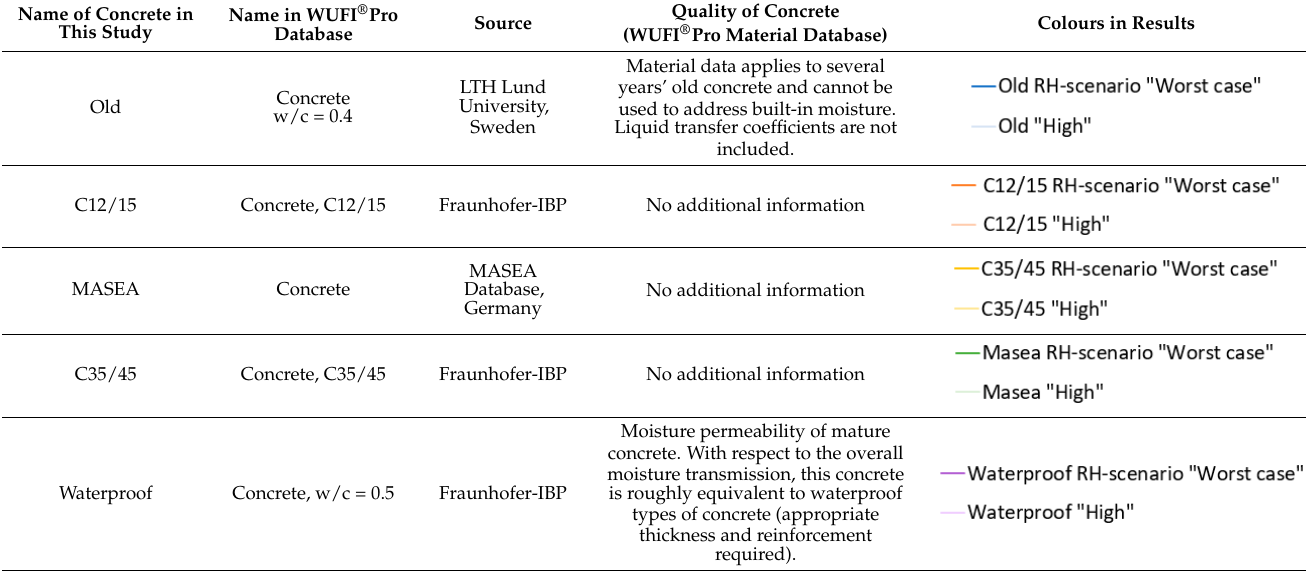
Table 1. Types of concrete used in hygrothermal simulations.